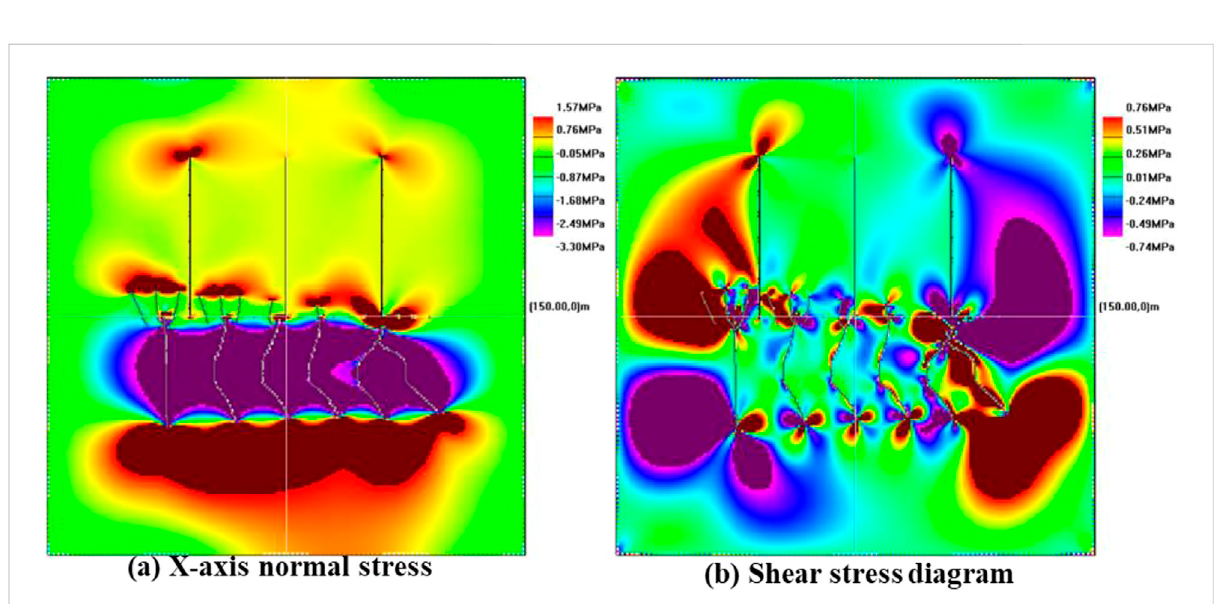
FIGURE 16 Stress fi eld distribution of natural fractures with an initial length of 1